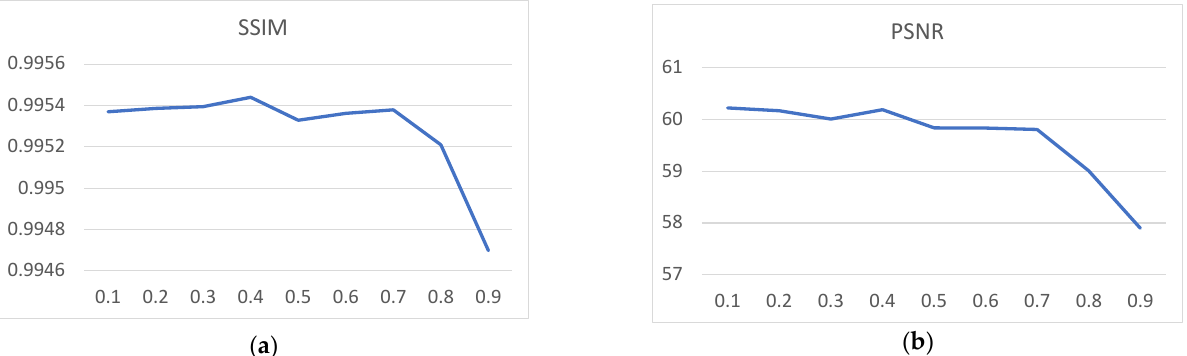
Figure 17. SSIM ( a ) and PSNR ( b ) of the rendered image with the increasing of 𝜔 in USM.